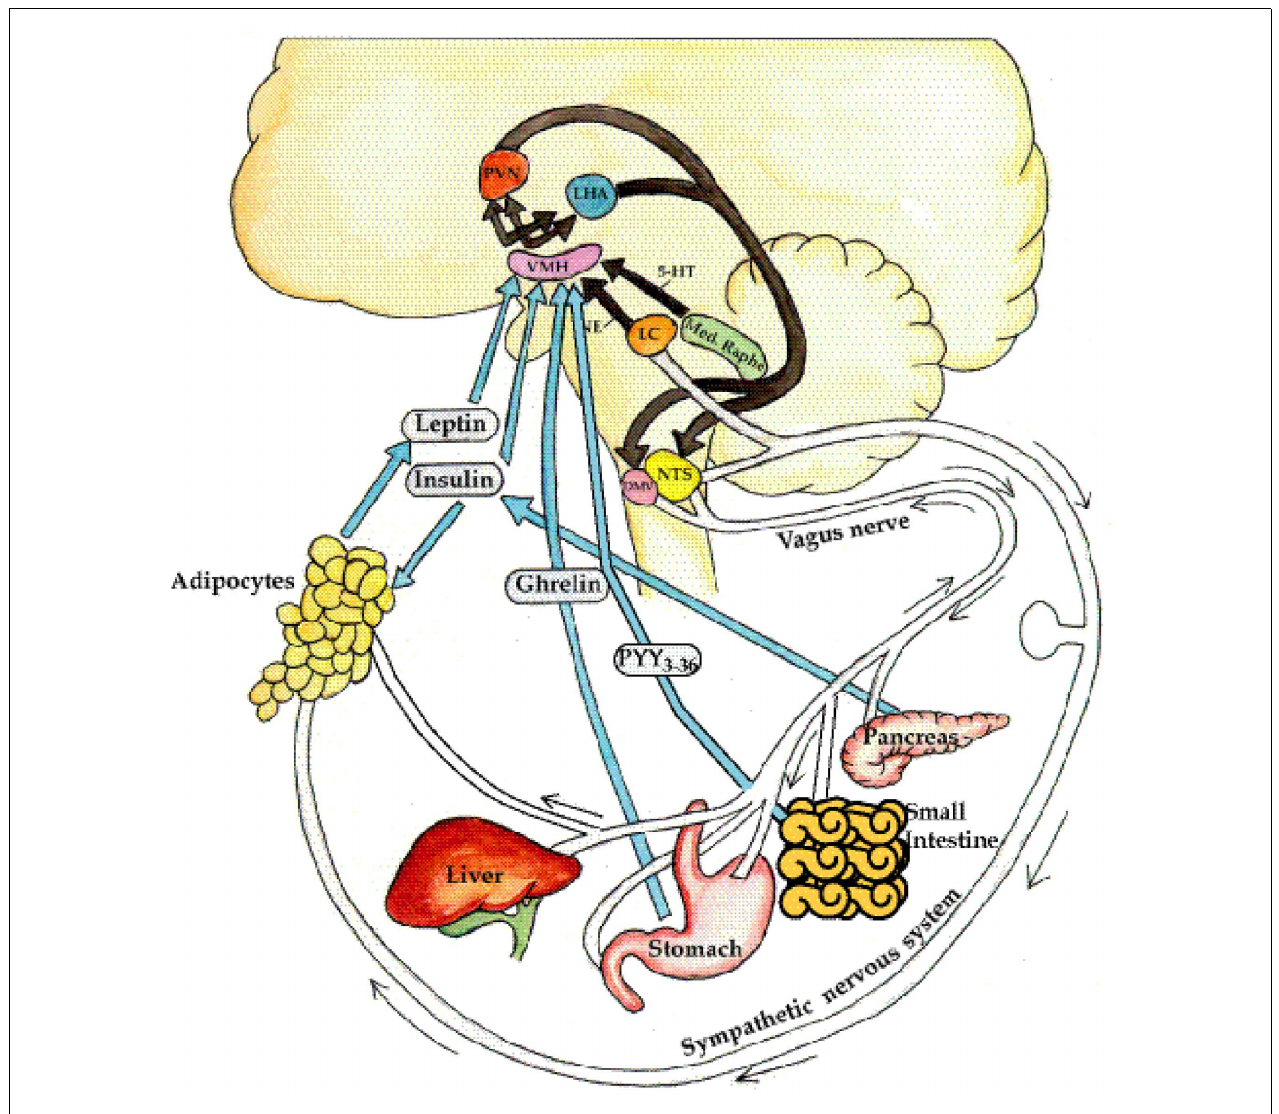
signals from these areas in turn stimulate the sympathetic nervous system (SNS) to expend energy by activating β 3 -adrenergic receptors and uncoupling proteins in the adipocyte, to release energy the form of lipolysis, heat, or physical activity. Conversely, the parasympathetic nervous system (efferent vagal) increases insulin secretion, with resultant adipogenesis and energy storage, and also increases insulin sensitivity through direct effects on the adipose tissue (Lustig, 2006). From Nature Publishing Group, with